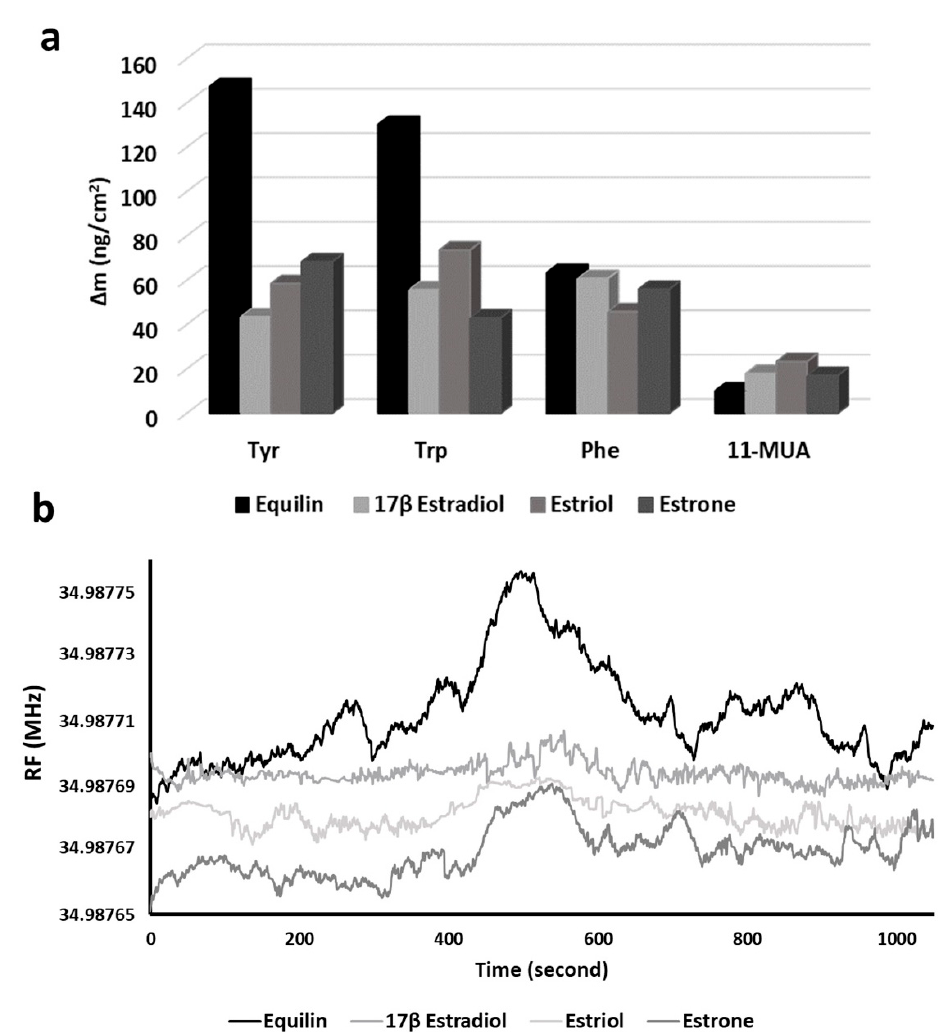
Figure 7. Comparison of response of EDCs on Tyr-, Trp- and Phe-modified QCM nanosensors ( a ) and resonance frequency change of EDCs with Tyr-modified QCM nanosensor ( b ).